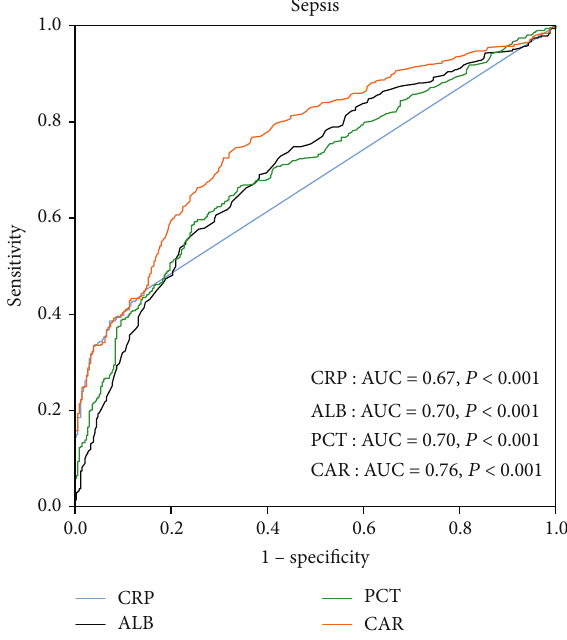
Figure 1: ROC curve of CRP, ALB, PCT, and CAR in predicting sepsis in neonates with